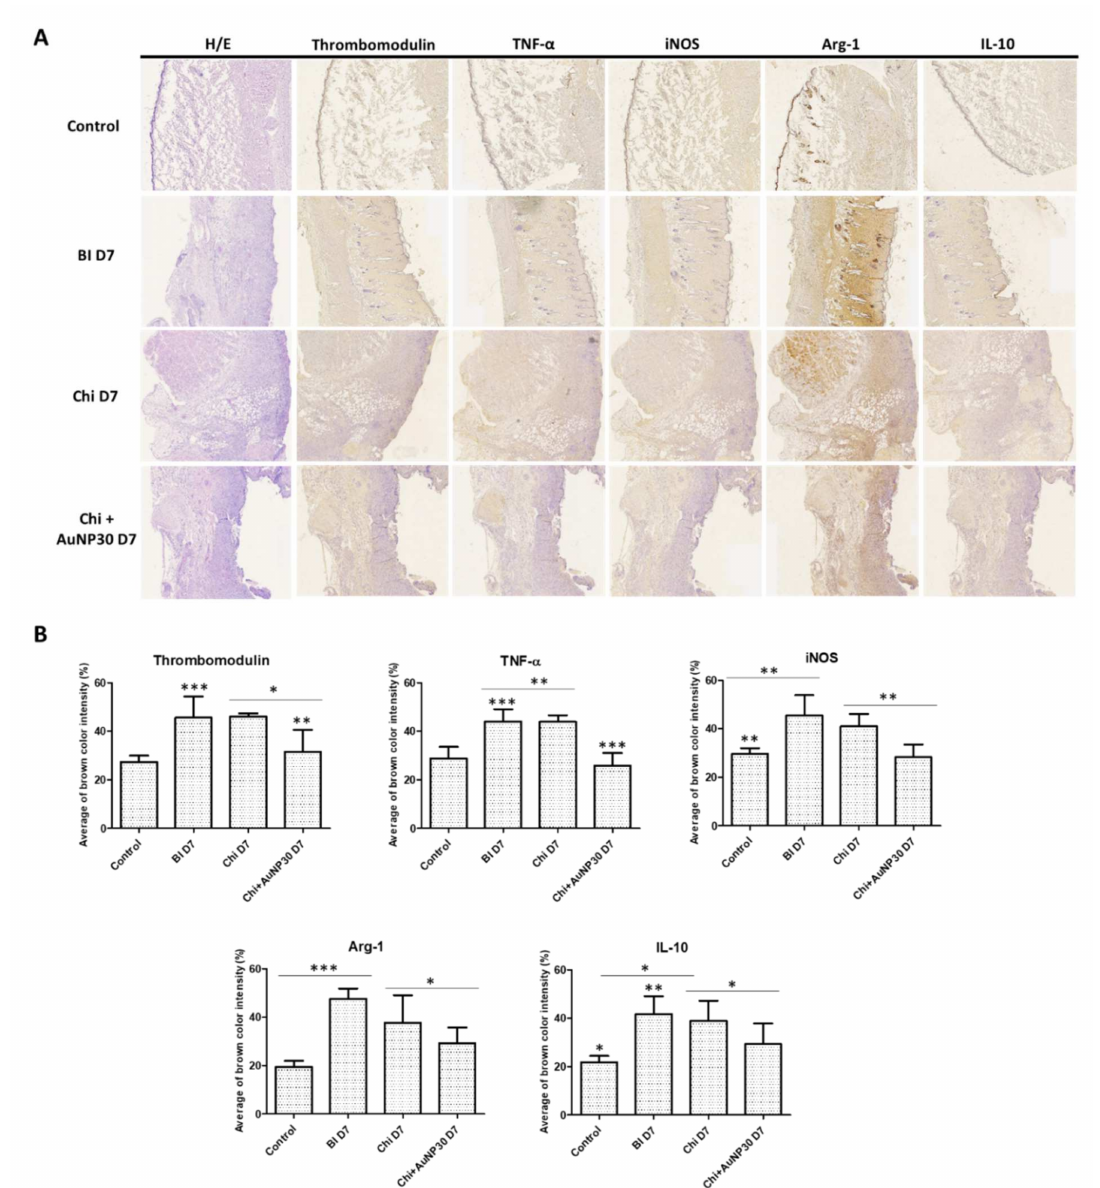
Figure 4. Histological and immunohistochemistry analysis of rat burn wound tissues in the con- trol, lesion, chitosan dressing, and AuNP-coated chitosan dressing groups. ( A ) Skin tissues stained for H&E, TM, TNF- α , iNOS, Arg-1, and IL-10 markers, respectively; ( B ) Semi-quantitative anal- ysis of the relative amounts of brown stained-positive cells with all markers amongst all groups. Control = normal control group; BI D7 = lesion control group day 7 post-wounding; Chi D7 = chi- tosan dressing treatment day 7 post-wounding; Chi + AuNP30 D7 = AuNP-coated chitosan dressing treatment day 7 post-wounding; * p < 0.05, ** p < 0.01, *** p <